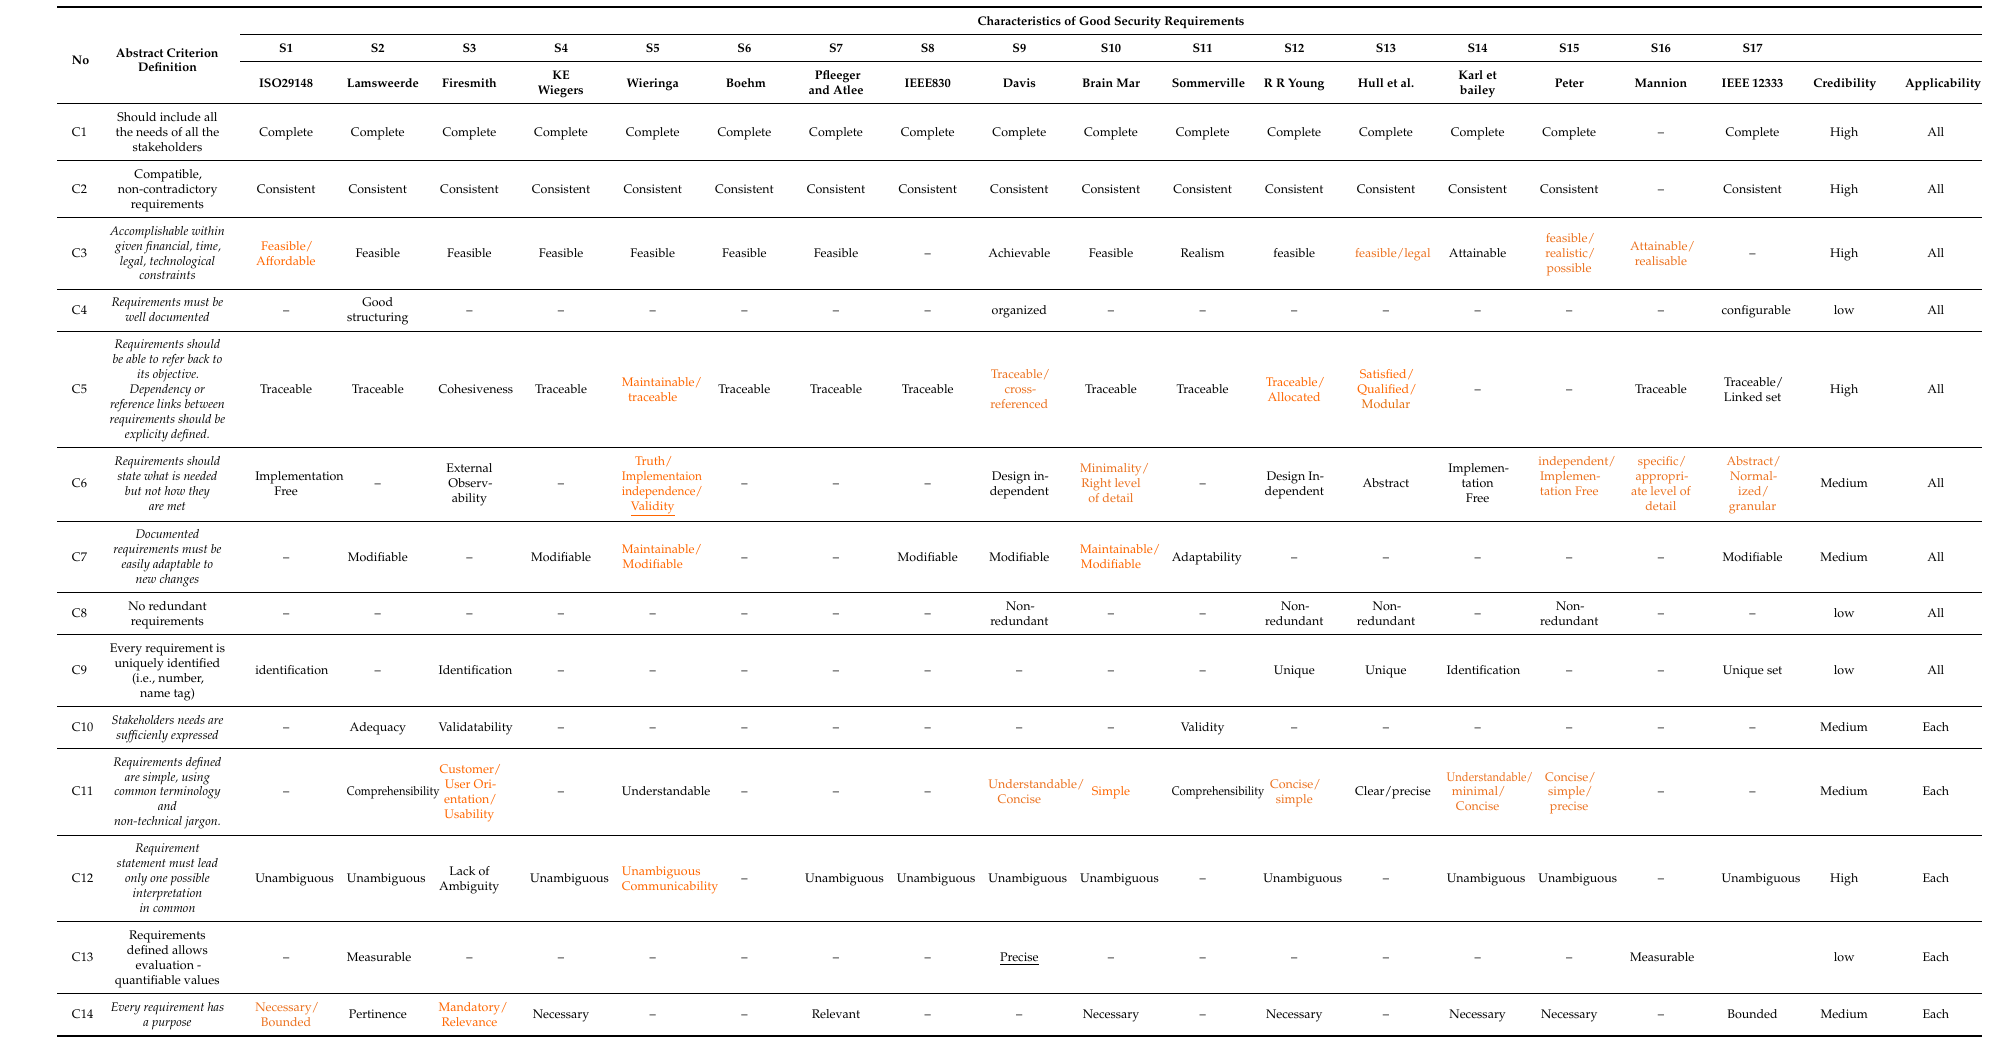
Table 2. Characteristics of good security